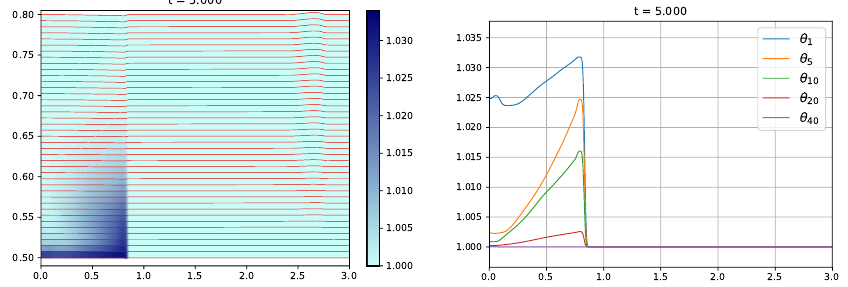
Figure 23. Evolution of the density driven current at t = 5 s.